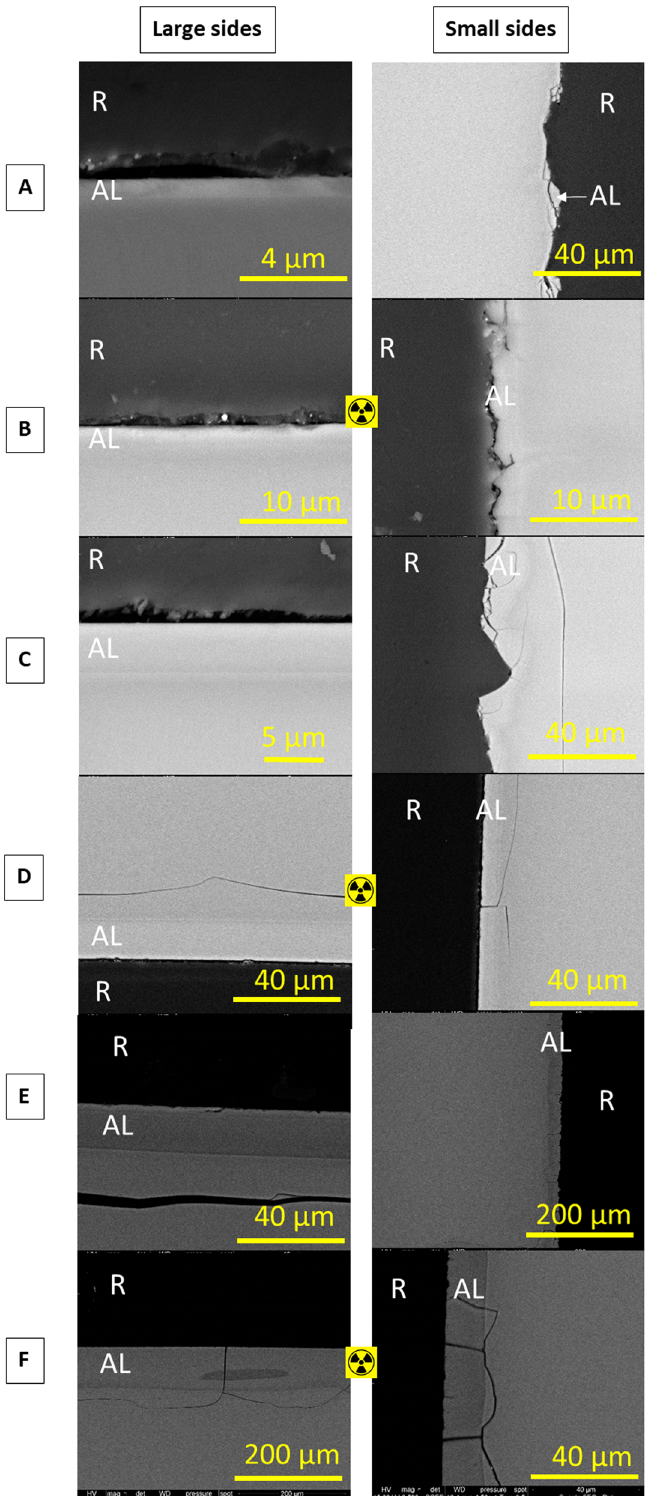
Fig. 6 Back scattered electron-SEM images of alteration layers formed on all samples. A pH9 non-irradiated. B pH9 irradiated. C pH7 non- irradiated. D pH7 irradiated. E pH3 non-irradiated. F pH3 Irradiated. In the fi rst column are shown alteration layers formed on the large faces of the coupons. In the second column are shown the alteration layers formed on a small side of the corresponding coupon. For a given coupon, it is not certain that all the four small sides display the same pattern. R resin, AL alteration layer. Nearby the AL is the uncorroded